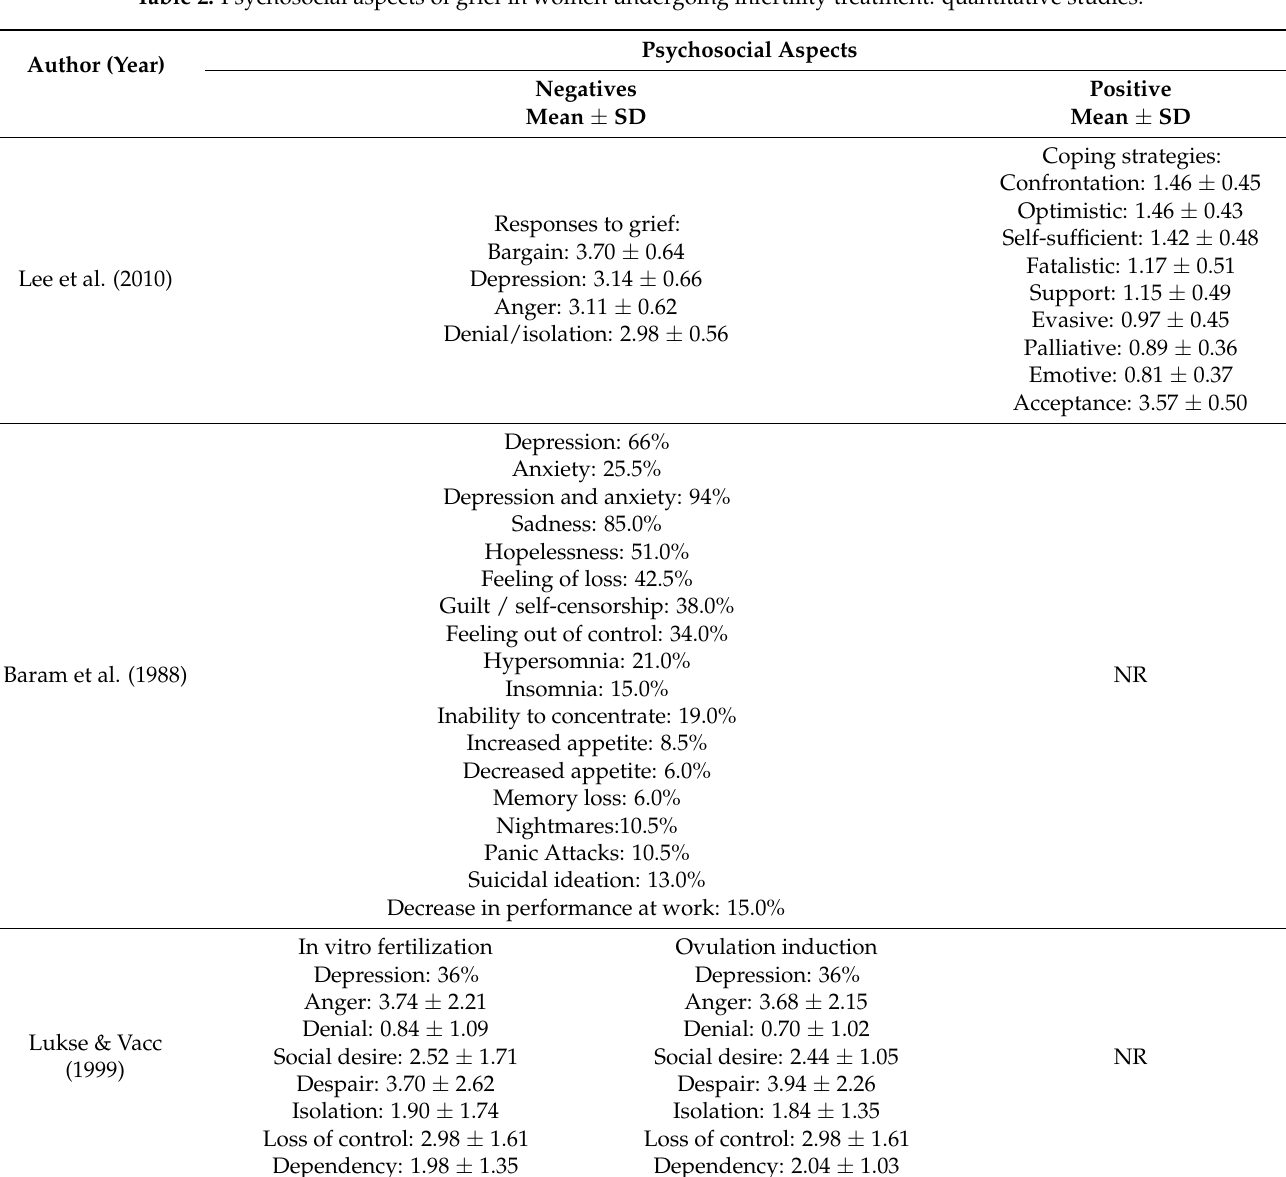
Table 2. Psychosocial aspects of grief in women undergoing infertility treatment: quantitative studies. Author